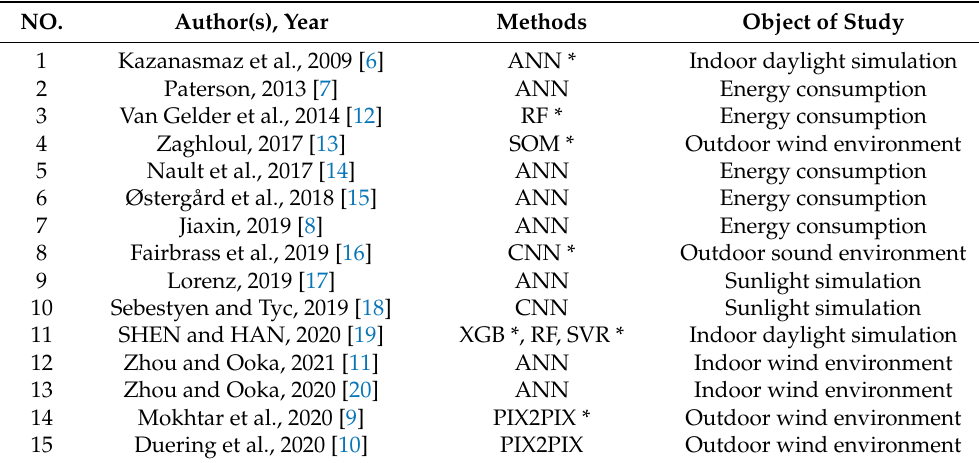
Table 1. Summary table of studies on building physical environment related to neural